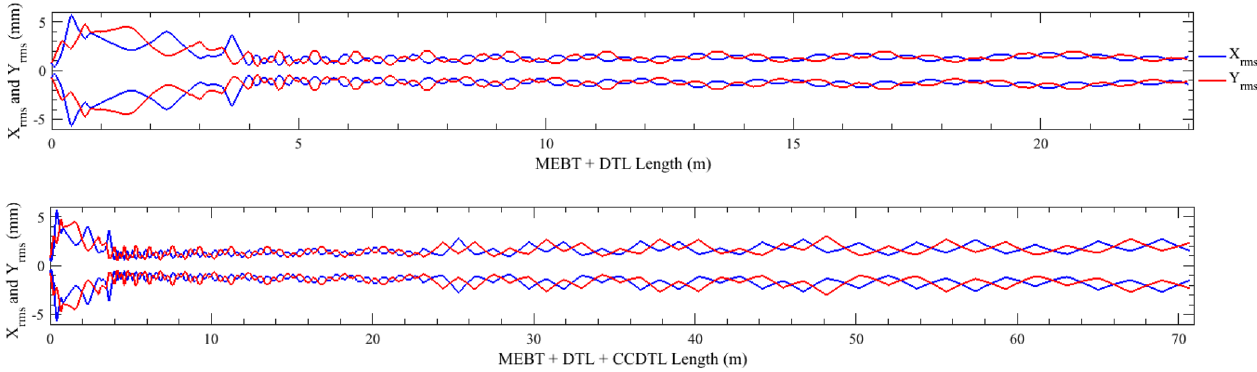
FIG. 10. Beam tracking from RFQ output plane to the end of LINAC4 structure, MEBT þ DTL (top), MEBT þ DTL þ CCDTL þ PIMS (bottom).